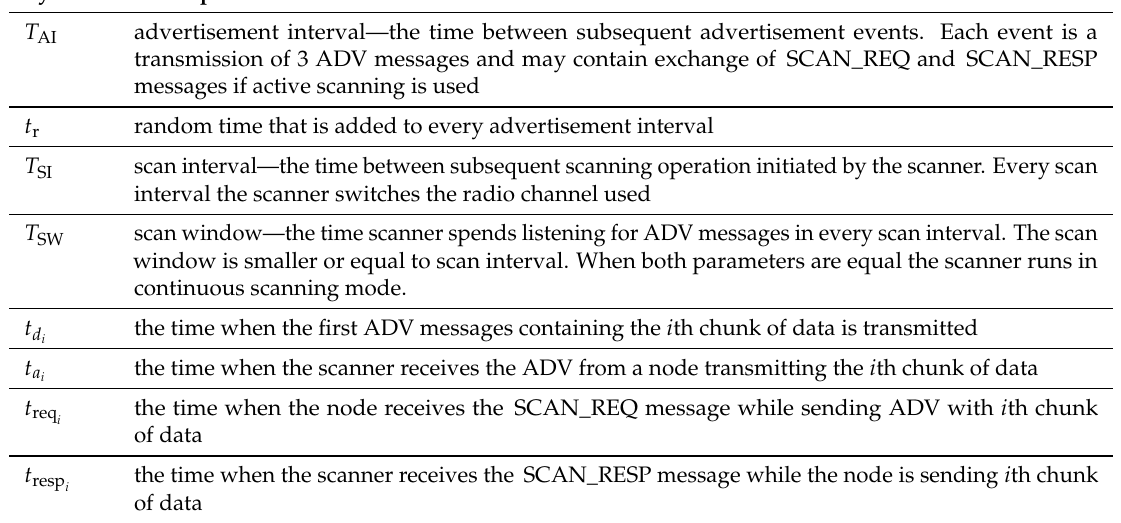
Table 2. Symbols used in the article to describe operation of the BLE nodes and the